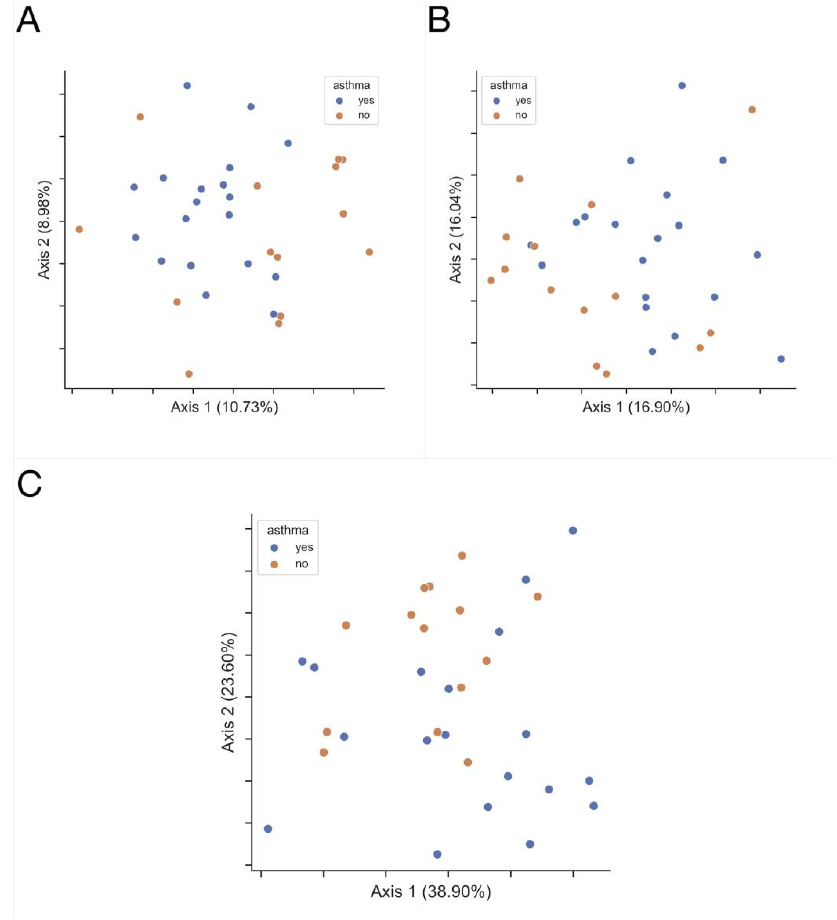
Figure 4. The microbiota of lower airways differs between asthmatics (blue) and HC (orange). Principal coordinate analysis (PCoA) plots capturing the beta diversity among EBC samples, for ( A ) Jaccard, p = 0.018; ( B ) Bray-Curtis, p = 0.039 and ( C ) Weighted UniFrac, p = 0.035.